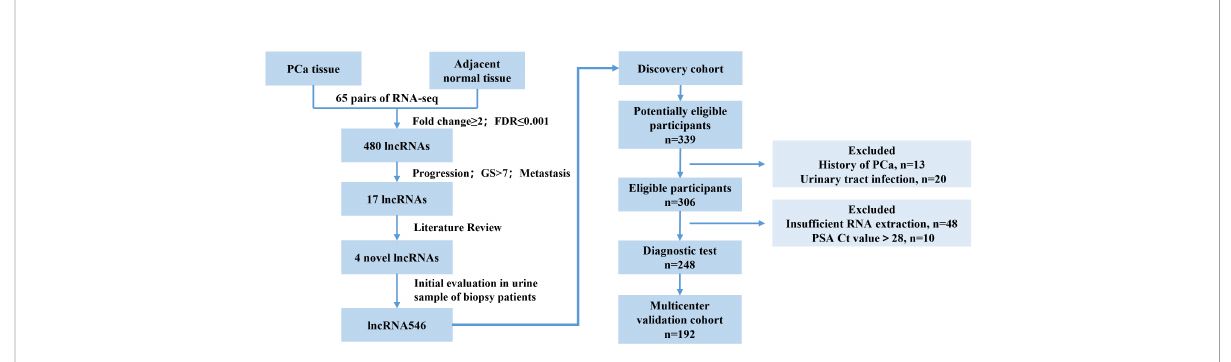
FIGURE 1 Flow diagram of evaluation and multi-institutional validation for the diagnostic value of urinary lncRNA546 in prostate cancer. PCa, prostate cancer. FDR, false discovery rate. GS, Gleason